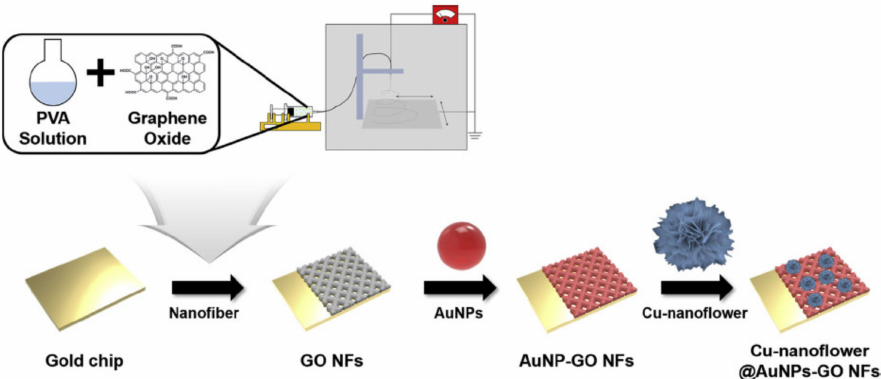
Schematic of Cu–nanoflower@AuNPs–GO nanofiber-based electrochemical nano- biosensor fabrication for glucose detection (reprinted with permission from Ref. no. [170], copyright 2020,